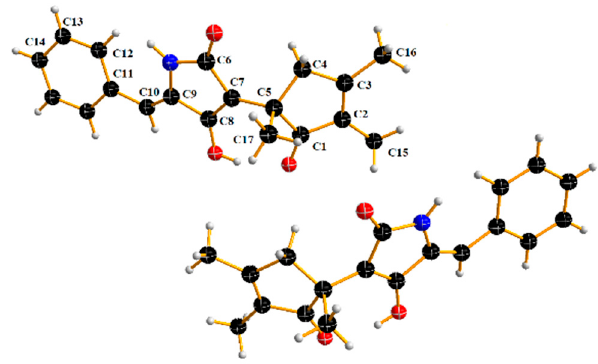
Figure 4. ORTEP diagram showing the structure of a racemate ( ± )- 1 in the crystal. Table 2. Anti-inflammatory effects of compounds 1 – 5 on the production of NO in lipopolysaccha- ride (LPS)-stimulated RAW264.7 cells.